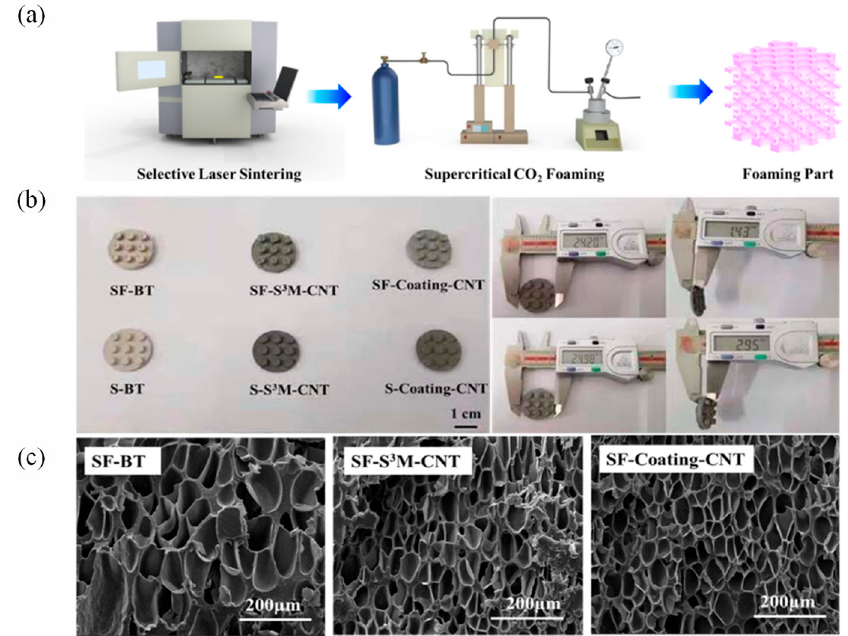
Figure 8. ( a ) Schematic diagram of the preparation of porous foam using Sc-Co 2 . ( b ) Actual photo- graph of printed device. ( c ) SEM image of pore morphology [116]. Reprinted with permission from Qian and Kang. (2021). Copyright © 2021 American Chemical Society .